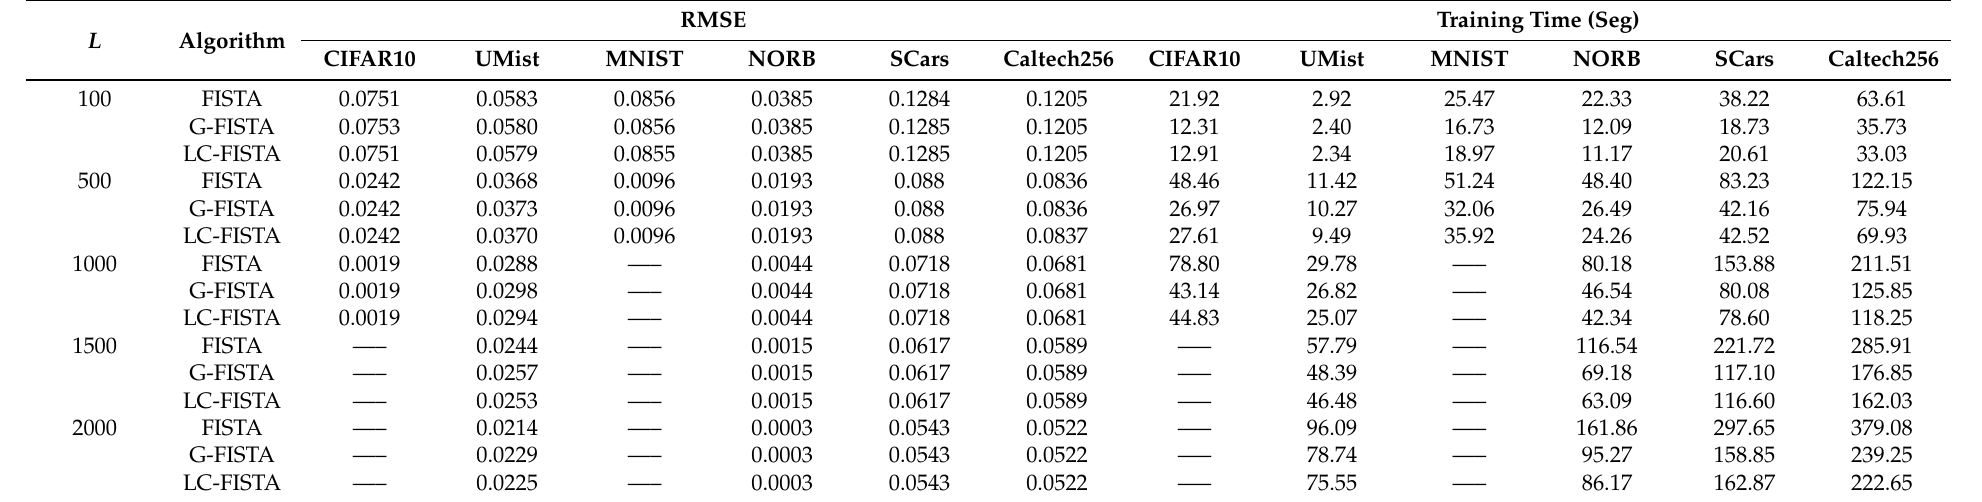
Table 4. Training times and RMSE values achieved by FISTA, G-FISTA, and LC-FISTA for training of the